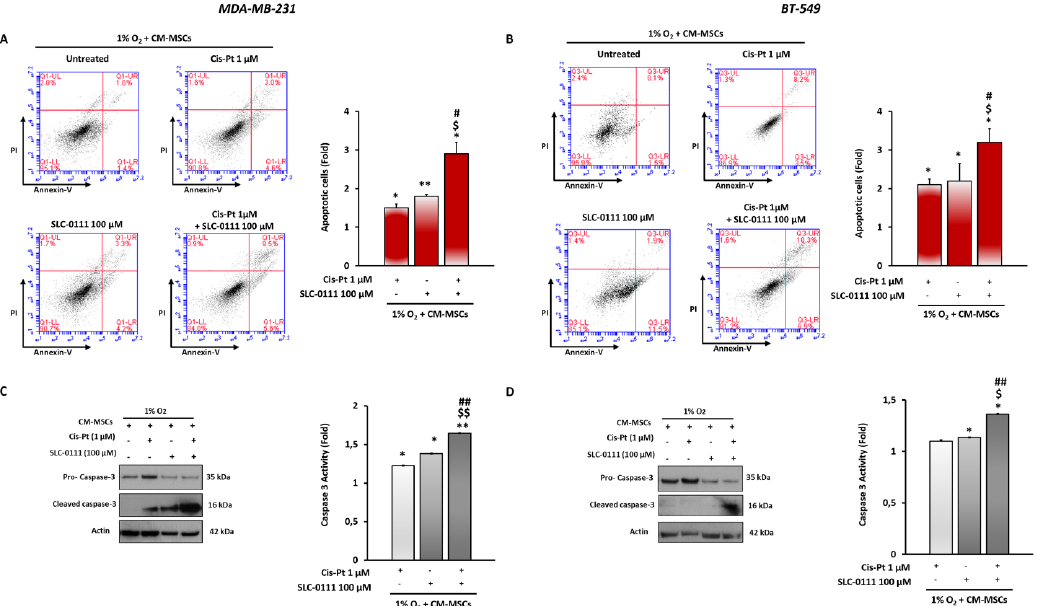
Figure 5. SLC-0111 potentiates the effect of Cis-Pt in increasing apoptotic programs in TNBC cells. MDA-MB-231 ( A ) and BT-549 ( B ) cells grown for 48 h in the presence of CM-MSCs and hypoxia (1% O 2 ) and treated with Cis-Pt (1 µM), SLC- 0111 (100 μM) and a combination of the two drugs were stained with annexin V/PI and subjected to flow cytometry analysis. Analysis of expression levels